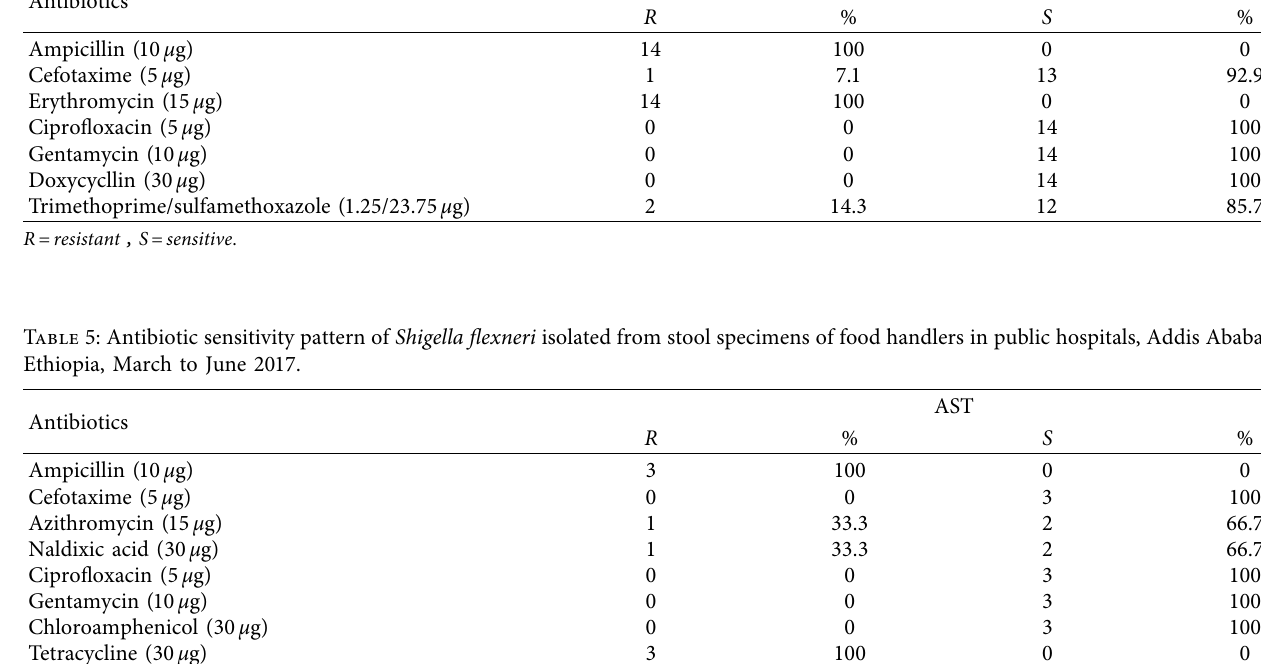
Table 4: Antibiotic sensitivity pattern of Salmonella isolated from stool specimens of food handlers in public hospitals, Addis Ababa, Ethiopia, March to June 2017. Antibiotics